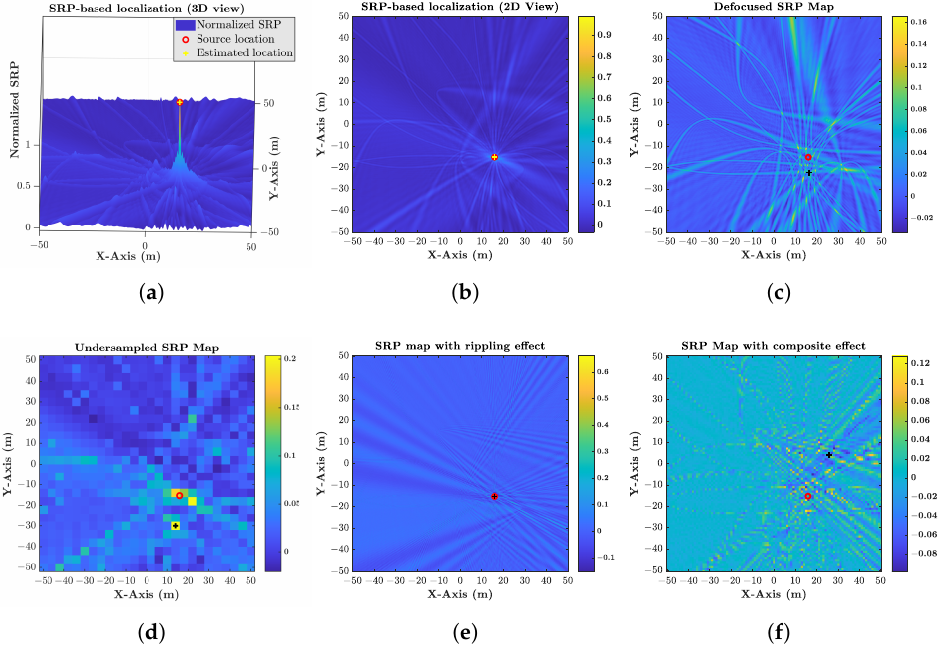
Figure 1. Comparison of the ideal steered response power (SRP)-based source localization in an ideal case and with the unexpected effects (the symbols “o” and “+” represent the source position and the estimated position, respectively): ( a ) SRP map (3D view); ( b ) Ideal SRP map (2D view); ( c ) defocus effect from steering time uncertainties; ( d ) undersampled effect from coarse grid; ( e ) rippling effect from band-pass generalized cross-correlations (GCCs); ( f ) combined